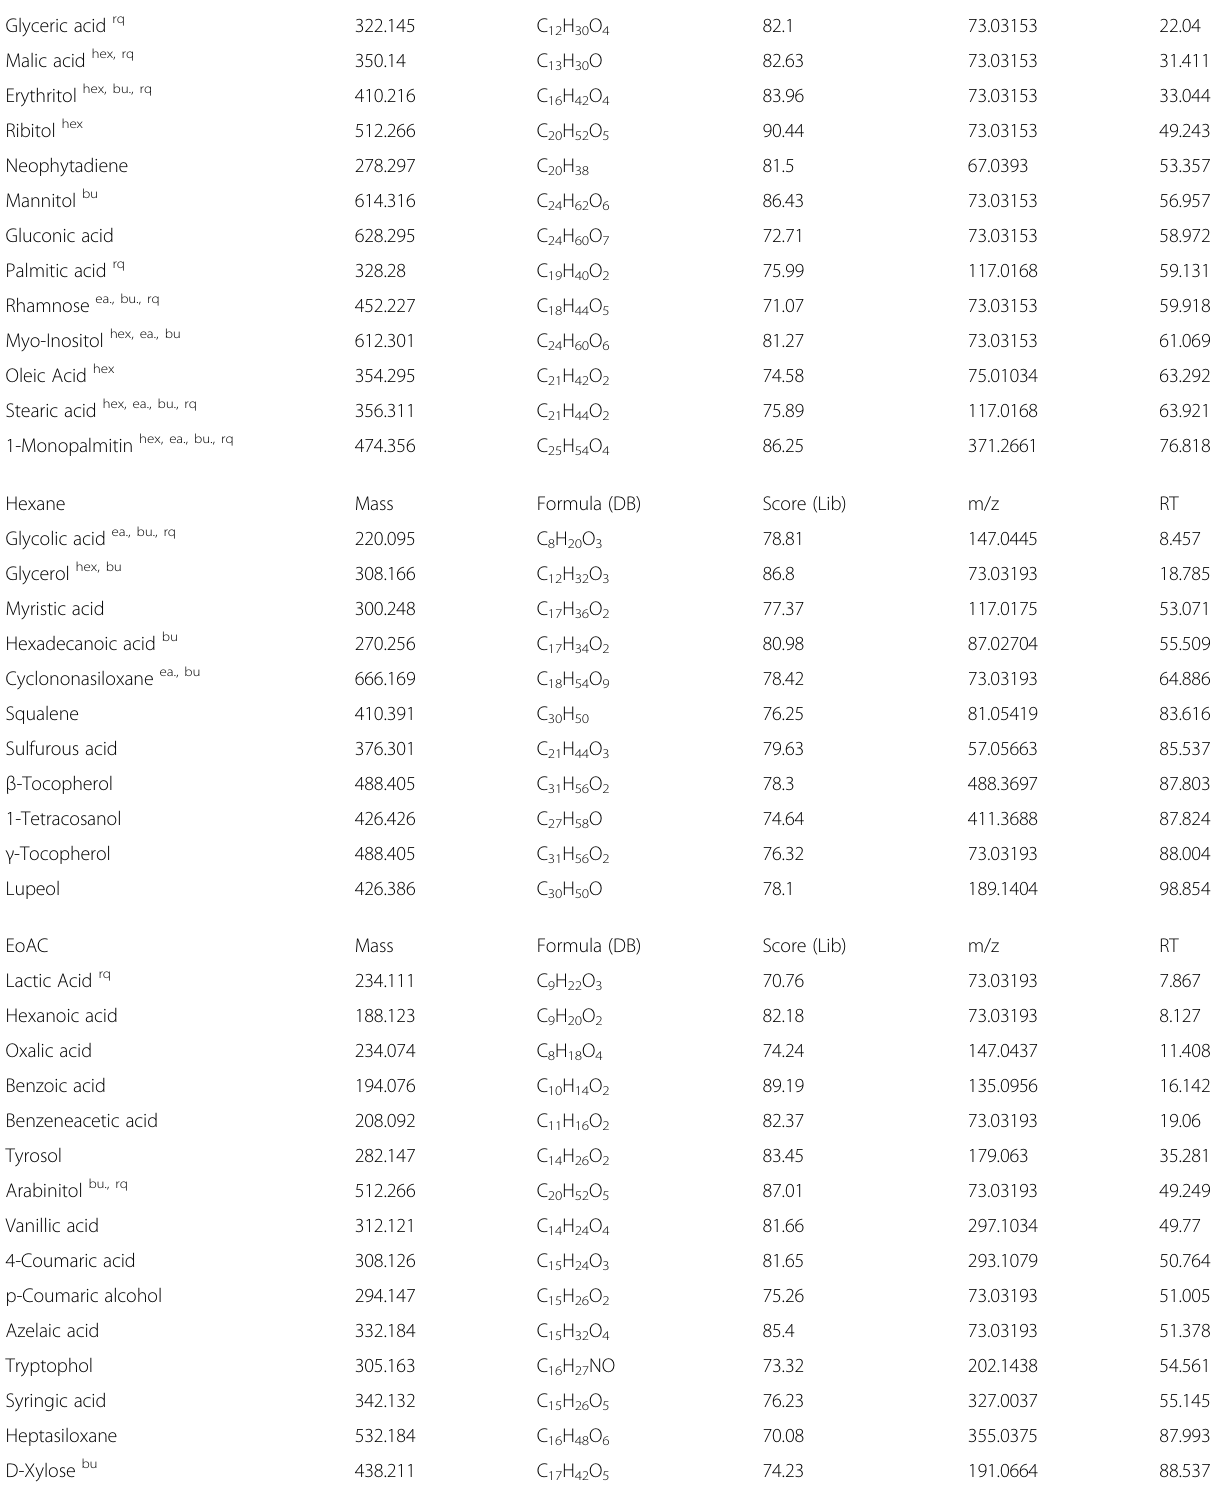
Table 3 Identified metabolites in methanol extract and its different fractions